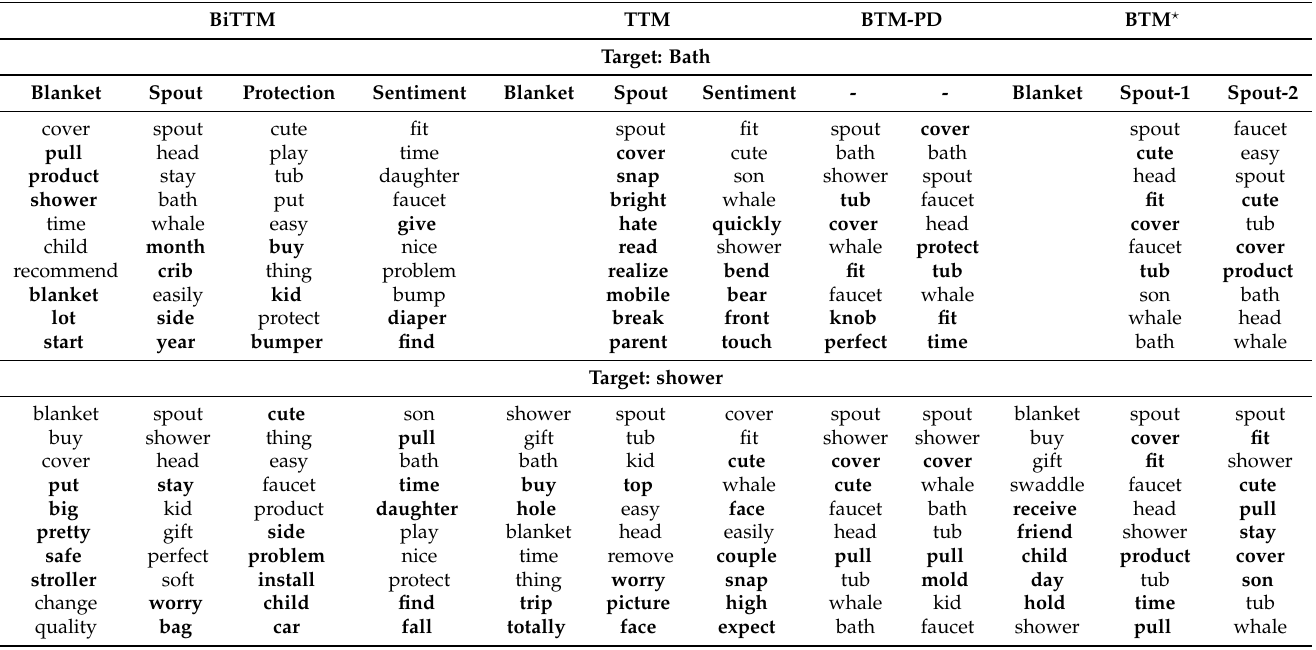
Table 8. The contents of topics on two approximate semantic targets in dataset